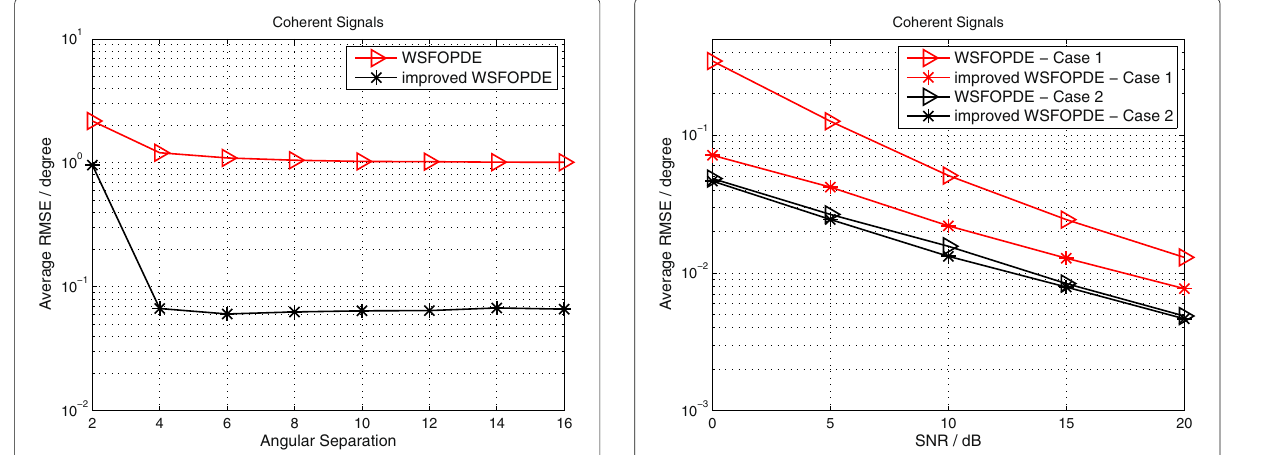
Fig. 6 The performance variation with angular separation between